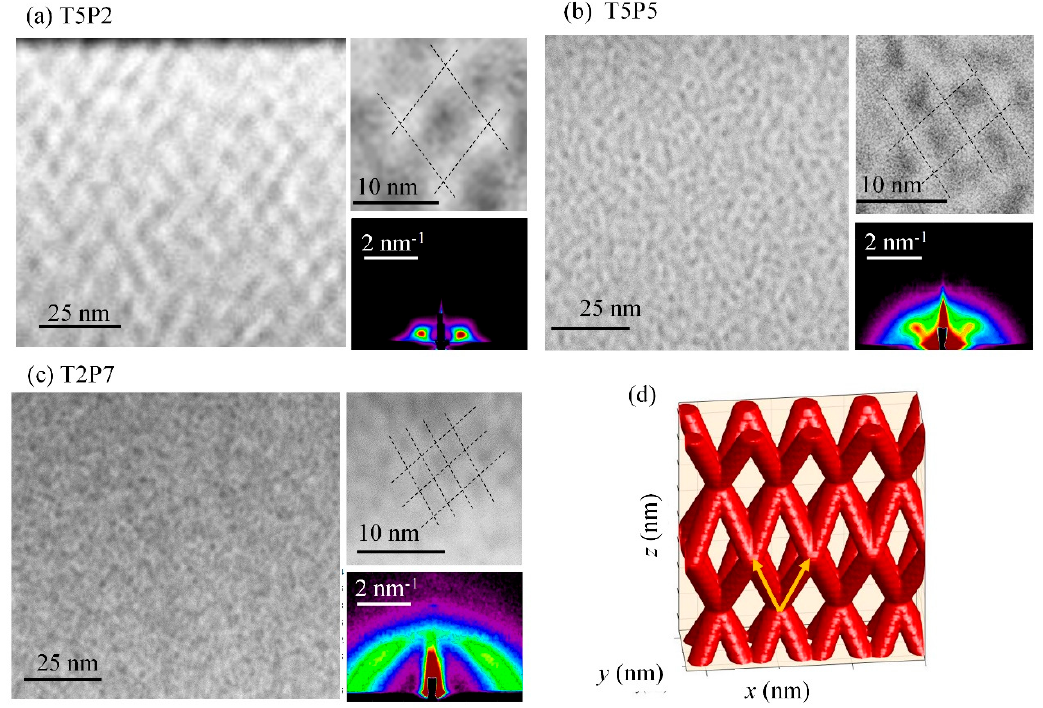
Figure 1. Typical structure of three-dimensional (3D) Ge nanowire networks. ( a – c ) a high-angle annular dark-field detector - Scanning transmission electron microscopy (HAADF-STEM) images of the films’ cross-sections. The insets show an enlarged part of the microscopy images, and the grazing incidence small angle x-ray scattering (GISAXS) map of the corresponding films, ( d ) schematically present the ideal structure of quantum wire (QW) networks with no disorder.